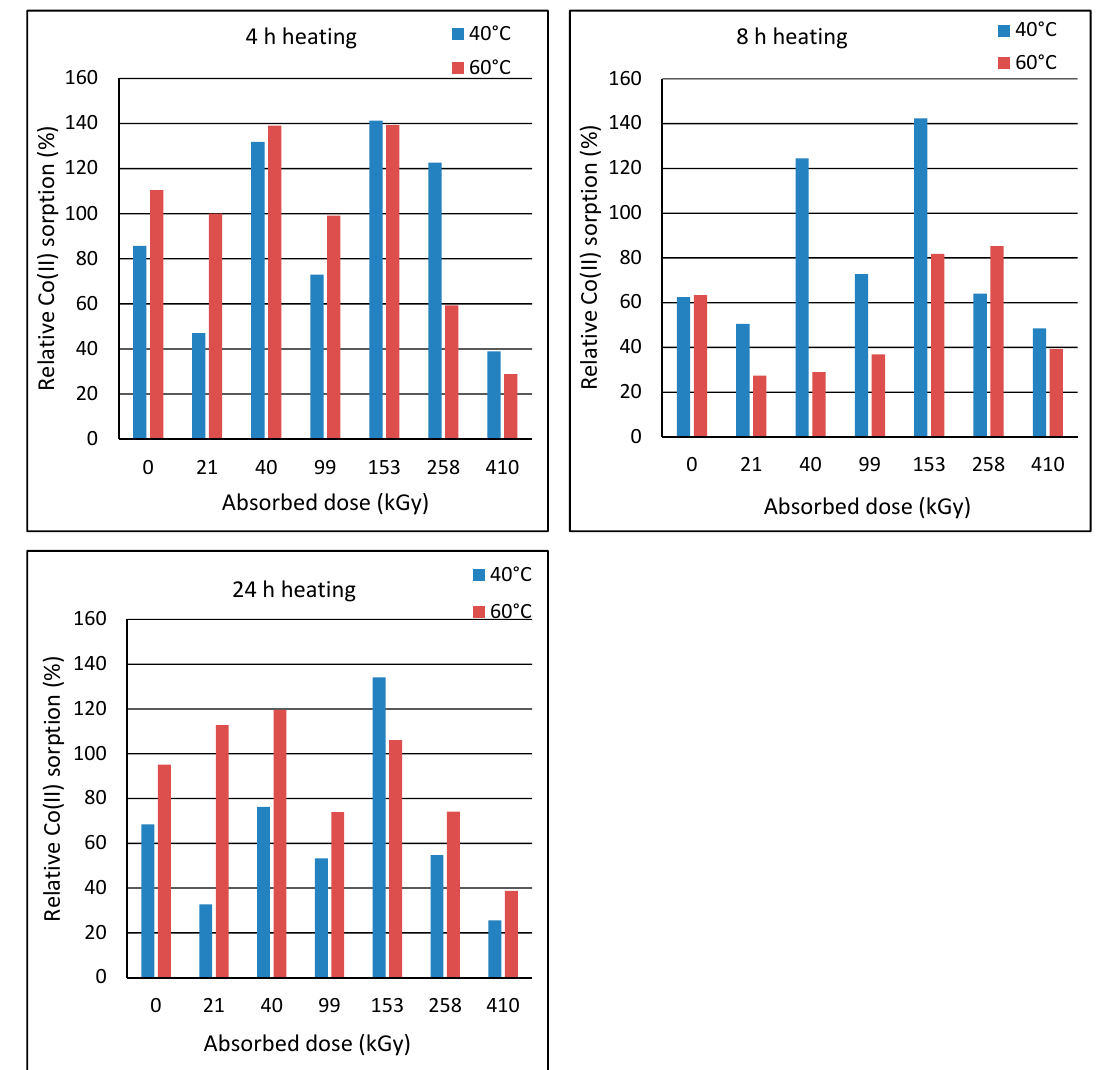
Figure 8. Co(II) sorption on the wool after 2 days from exposure and pre-heated to 40 or 60 °C for 4-8-24 h compared to the unheated wool; initial concentration of 150 mmol · dm − 3 .